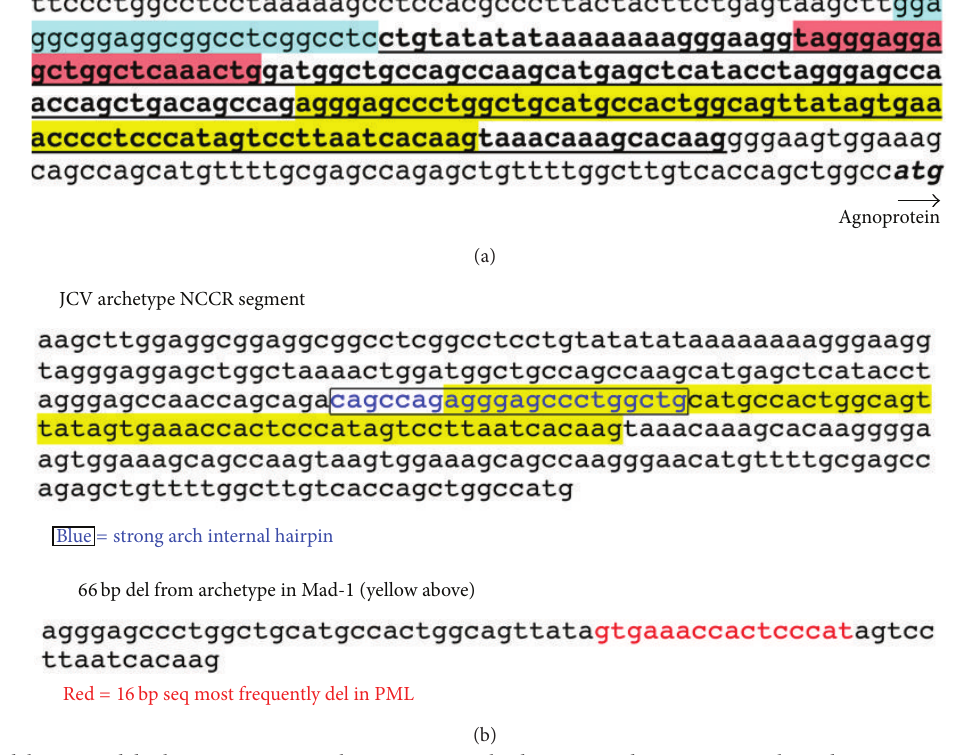
Figure 1: DNA deletions and duplication in a JCV archetype sequence leading to a Mad-1 sequence implicated in PML: position of an internal palindrome. (a) The sequence of the noncoding control region (NCCR) termed archetype [31] here is from strain JAL (gb:JX273163). The sequence rearrangements leading to Mad-1 have been documented [28, 39]. The core origin of DNA replication (ori, not altered) is shaded in light blue. A 23 bp deletion is shaded in red. A 66bp deletion is shaded in yellow. After shown deletions, the sequence underlined and in bold is tandemly duplicated in Mad-1. (b) A potentially stable internal hairpin, positioned at the 5 󸀠 end of the 66bp deletion, is typed in blue and boxed. A sequence most frequently deleted in several reported cases of PML [4] is located within the 66 bp deletion and typed in